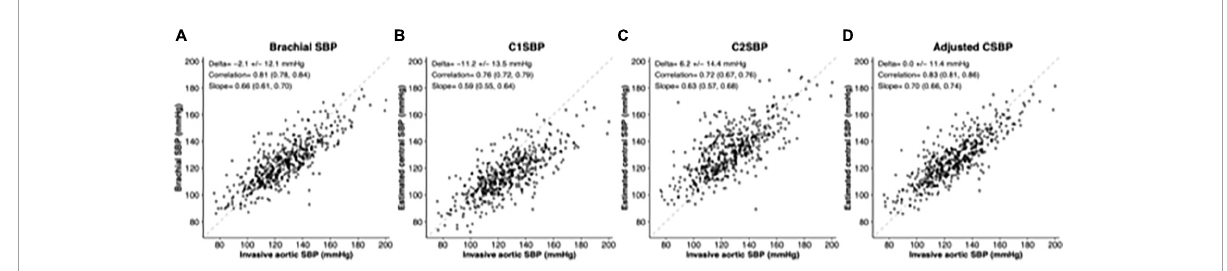
FIGURE1 Scatter plots of brachial SBP/estimated central SBP with invasive aortic SBP. Each gray dot represents the relationship between invasive aortic SBP and brachial SBP/estimated central SBP for a given individual. Correlation coefficients, regression slopes and mean accuracy for aortic SBP are displayed with their 95th confidence interval. (A) Brachial SBP; (B) C1SBP; (C) C2SBP; and (D) adjusted central SBP (full model). SBP, systolic blood pressure.